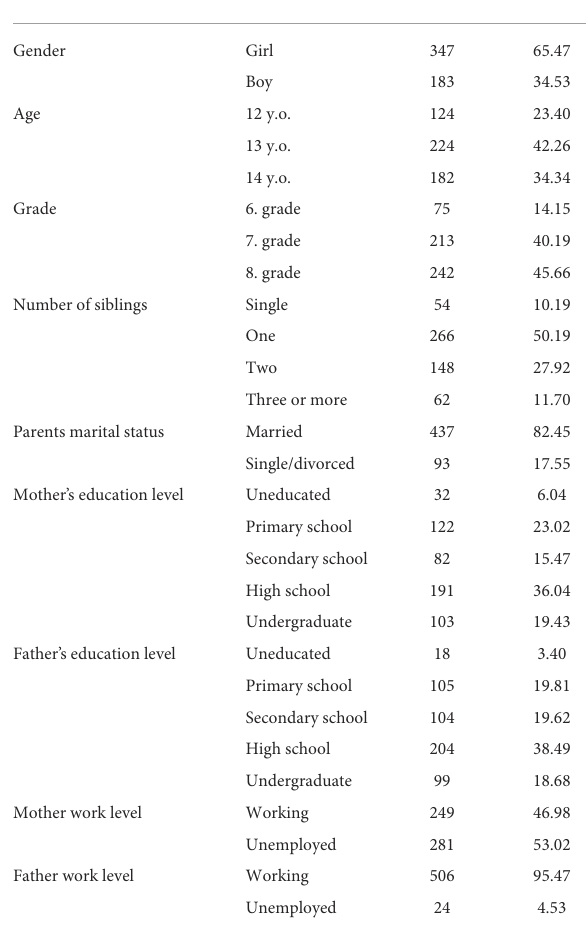
TABLE 1 Distribution of students according to their socio-demographic